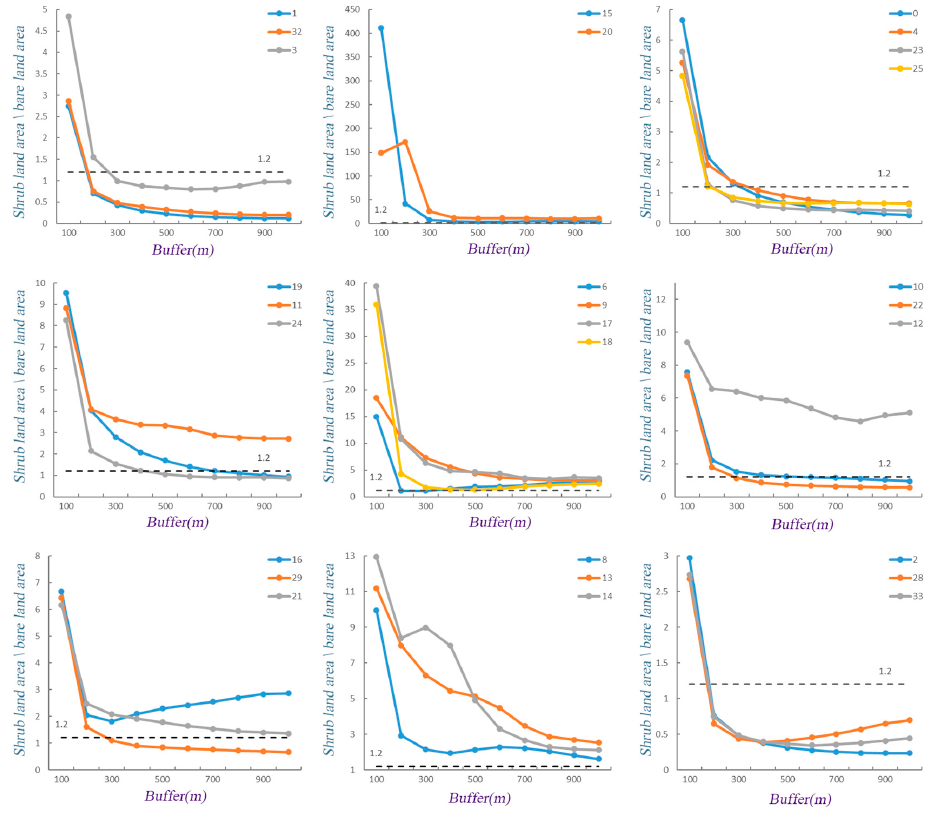
Figure 11. Optimal expansion distance of planned “source”. (Contains 28 planned ecological sources.).